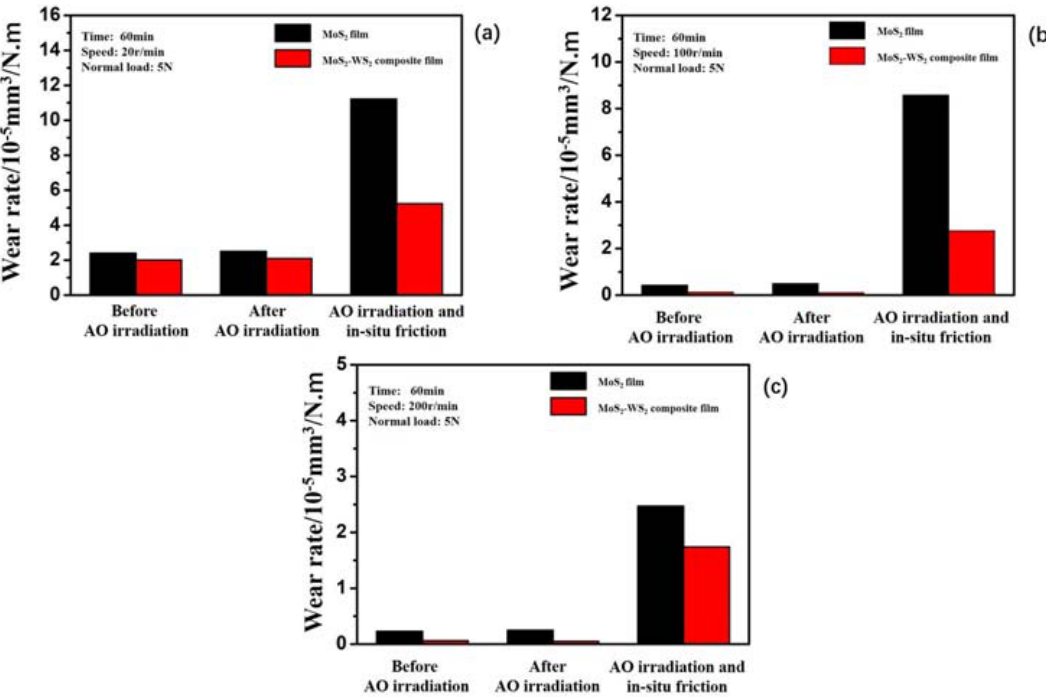
Figure 10. The wear rate of pure MoS 2 and MoS 2 –WS 2 composite film at different sliding cycles under different conditions: before AO ‐ irradiation, after AO ‐ irradiation, and with AO ‐ irradiation. ( a ) 1.2 × 10 3 cycles, ( b ) 6.0 × 10 3 cycles, ( c ) 1.2 × 10 4 cycles.